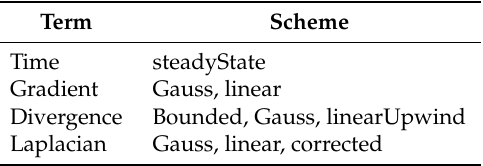
Table 1. Discretization schemes specified for the case studies.